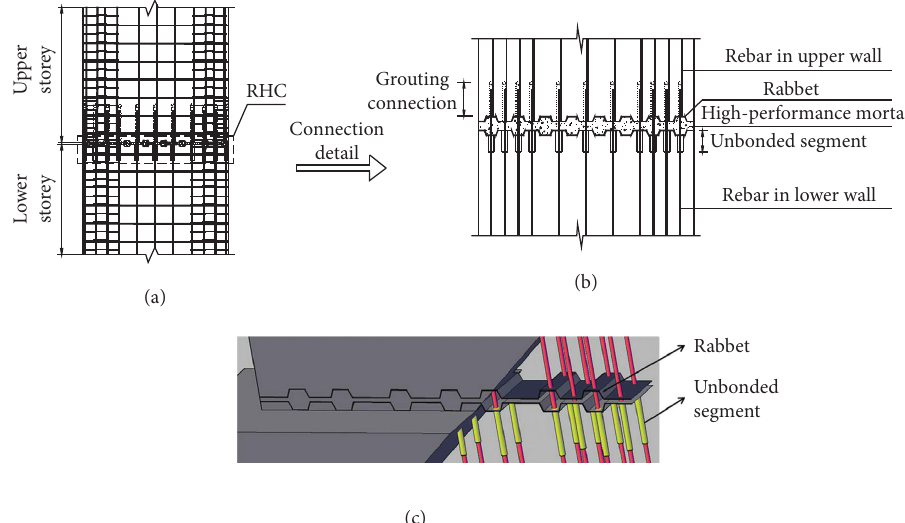
Figure 1: (a) RHC shear wall and (b, c) the RHC details (note: for the sake of clarity, the horizontal distribution rebars in the upper and lower walls are not shown in Figure 1(b)).